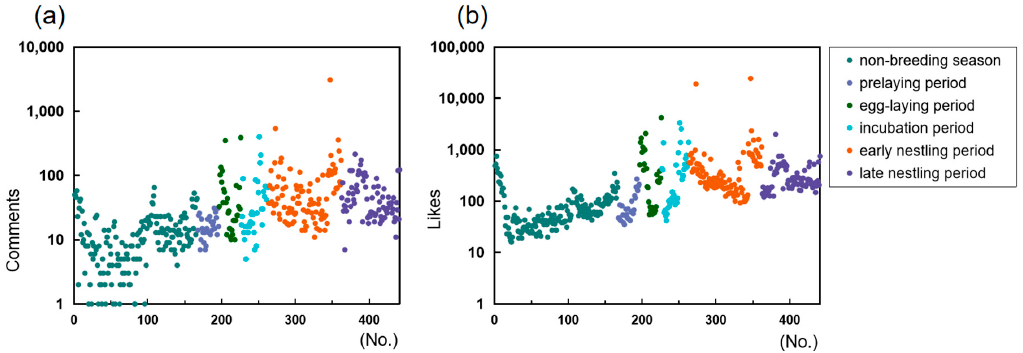
Figure 1. User attention based on different periods. ( a ) Number of comments on videos from differ‑ Figure 1. User a tt ention based on di ff erent periods. (a) Number of comments on videos from di ff er- ent periods of kestrels. ( b ) Number of likes on videos from different periods of kestrels. Notes: Of